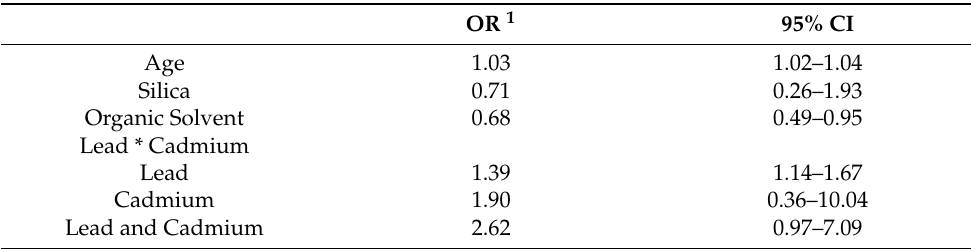
Table 4. The Adjusted Odds of EM by Cadmium and Lead exposure and their Co-Exposure, Silica, and Organic Solvents